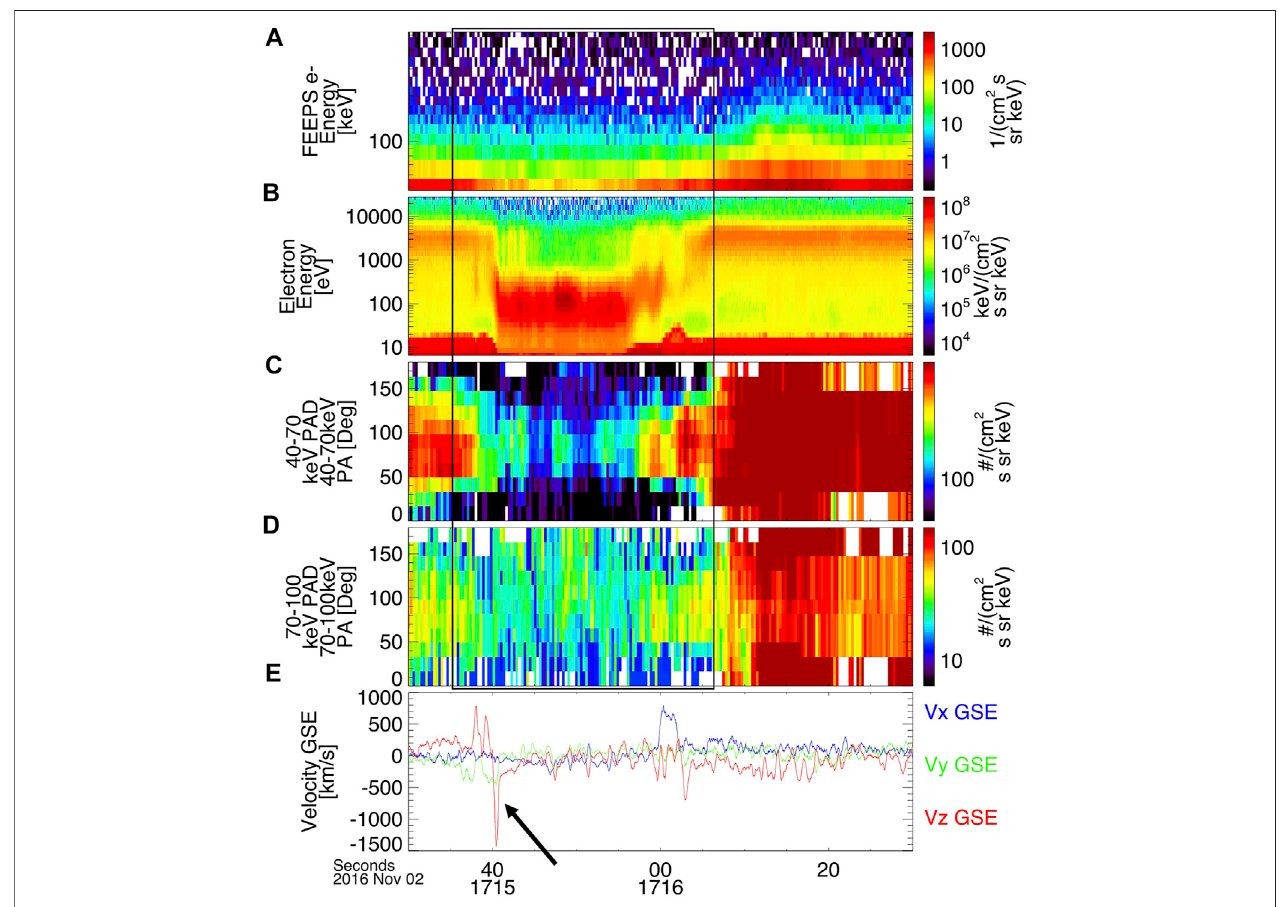
FIGURE 5 | An example of a boundary crossing event that showed evidence of reconnection at 17:15 on 2 November 2016. (A) FEEPS electron energies, (B) background thermal electron energies, (C) Pitch angle distribution at 40 – 70 keV, (D) Pitch angle distribution at 70 – 100 keV, (E) Electron velocity components in GSE coordinates. The box shows the time of the boundary layer crossing and the arrow points to the velocity reversal suggestive of a reconnection jet.